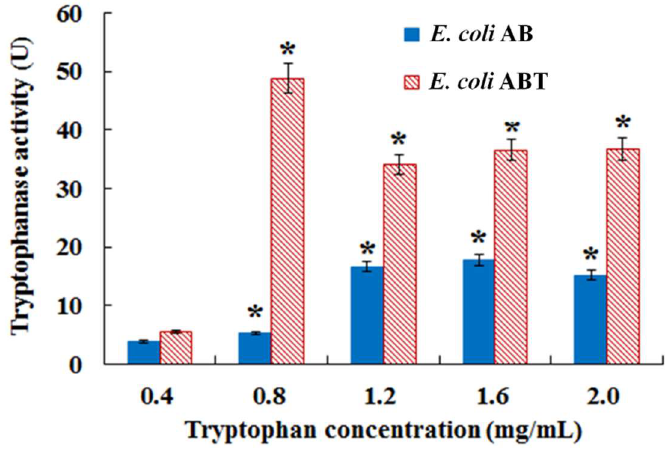
Figure 5. Tryptophanase activity in E. coli AB and E. coli ABT in fermentation with different concen- trations of tryptophan. Bars with asterisk (*) are significantly different ( p < 0.05).